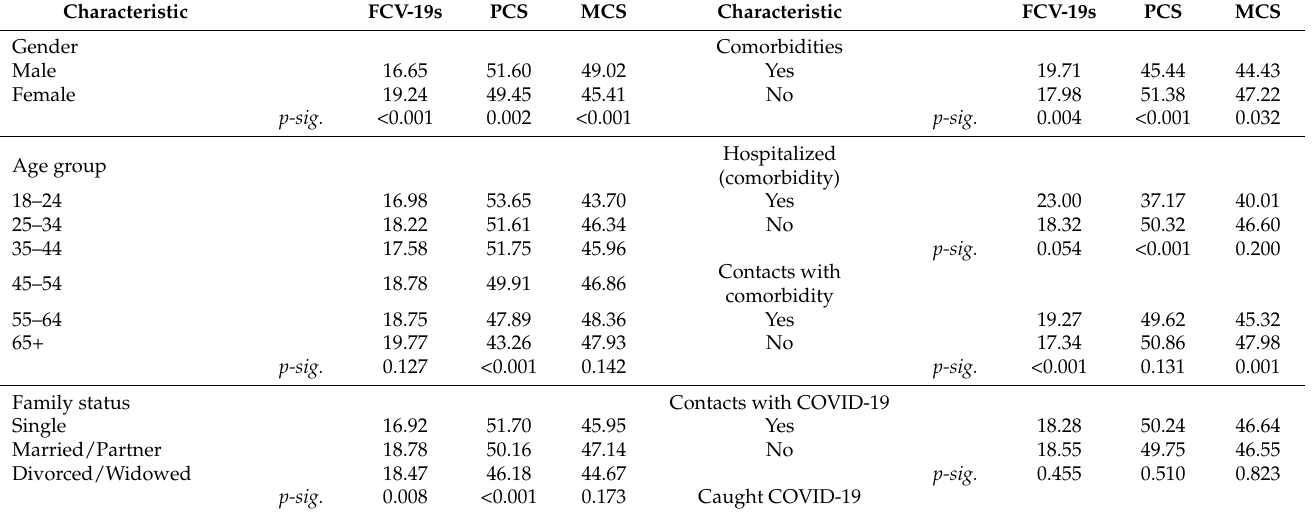
Table 4. Fear for COVID-19 and physical/mental health by demographic and health-related charac-